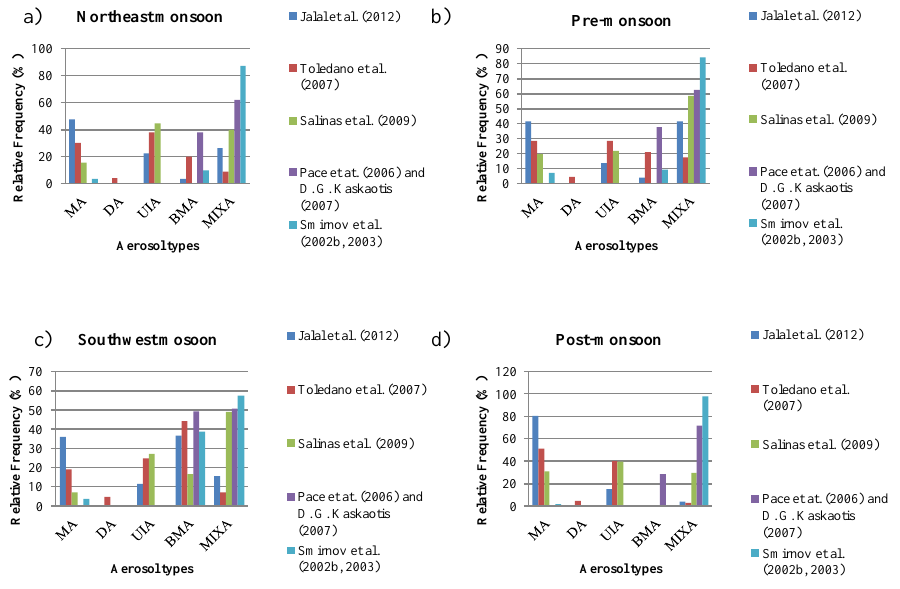
Figure 2. Classification of aerosol types for (a) northeast monsoon, (b) pre-monsoon, (c) southwest monsoon, and (d) post-monsoon based on AOD–Ångström 440 − 870 scatter plots by proposed thresholds.